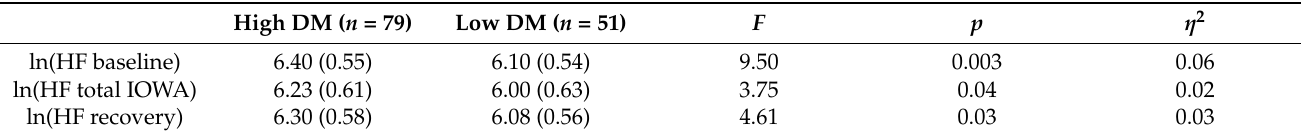
Table 2. Means (M) and standard deviations (SD) of ln(HF-HRV) in decision-making (DM) groups.